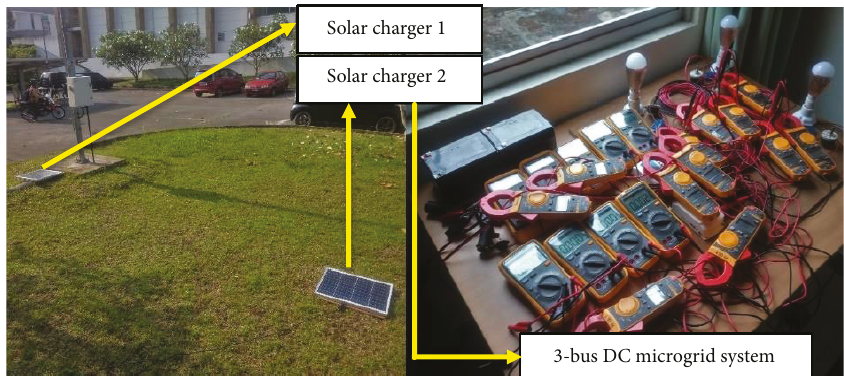
Figure 9: Experimental setup for the con fi guration of multiple sources.